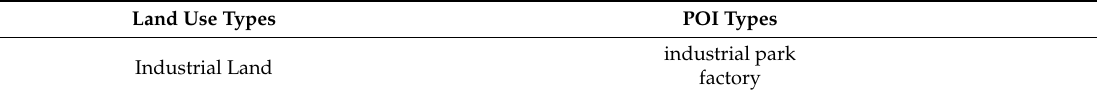
Table 1. Land use types and POI